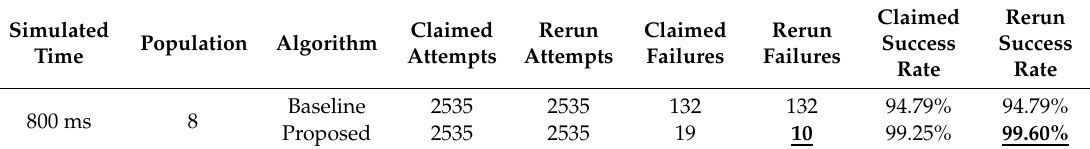
Table 11. Inconsistencies in